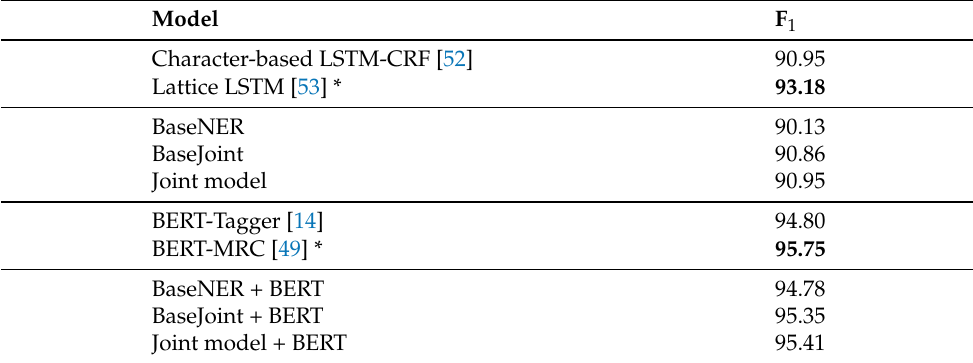
Table 6. F 1 -scores on MSRA (Chinese), * indicates the models were trained with the use of external labeled data.